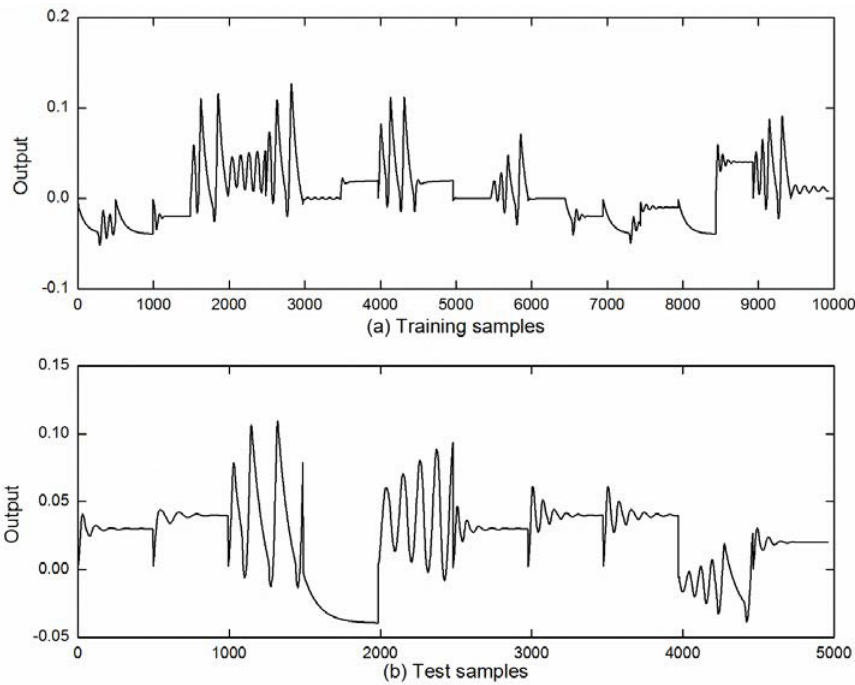
Figure 8. Training and test samples for PTGS model identification.